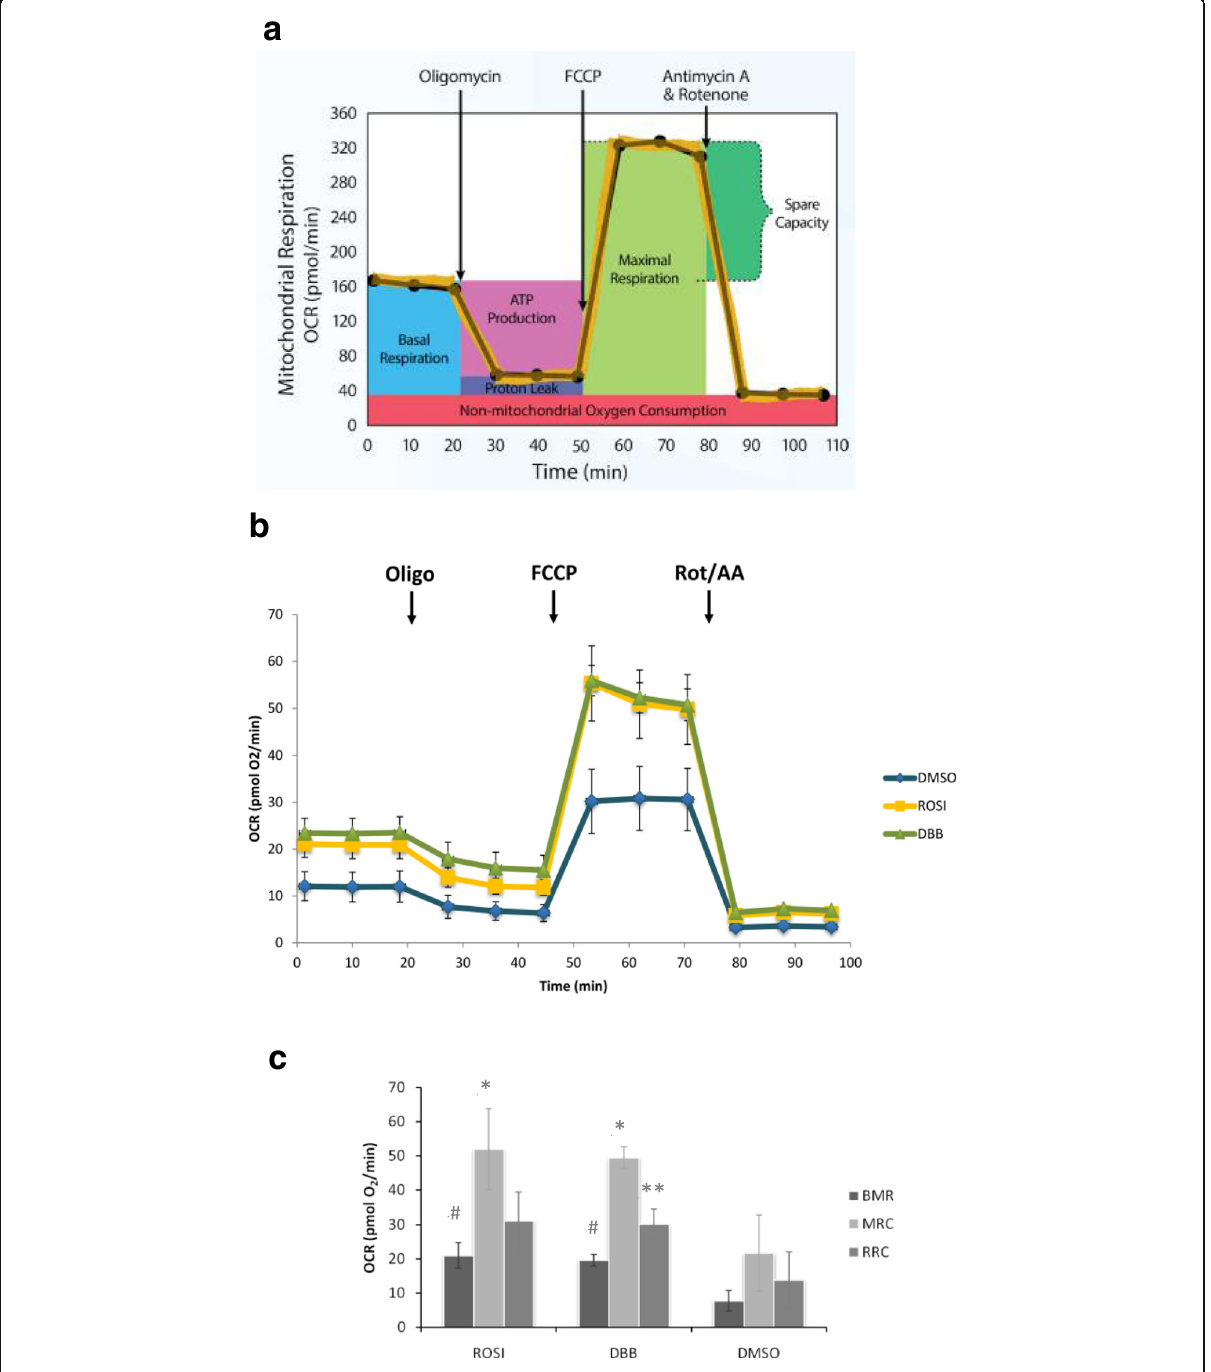
Fig. 5 Mito Stress Test Assay was used to determine the cellular mitochondrial function. (a) Seahorse XF Cell Mitro Stress Test profile illustrated the key parameters of mitochondrial function namely basal respiration, ATP production, proton leak, maximal respiration, and spare respiratory capacity. b OCR was measured in response to consecutive addition of oligomycin (Oligo) to inhibit adenosine triphosphate (ATP) synthase, the mitochondrial uncoupler carbonyl cyanide p-triflouromethoxyphenylhydrazone (FCCP), and complex I and III inhibitors (rotenone and antimycin A (Rot/AA) respectively. c Treatment with DBB for 7 days markedly increased the basal OCR or basal metabolic rate (BMR), ATP-linked OCR, and maximum OCR, mitochondrial respiratory capacity (MRC), and reserve respiratory capacity (RRC). # denotes statistical significance (ANOVA P < 0.05) as compared to 0.5% DMSO for BMR, * denotes statistical significance (ANOVA P < 0.05) as compared to DMSO for MRC, and ** denotes statistical significance (ANOVA P < 0.05) as compared to DMSO for